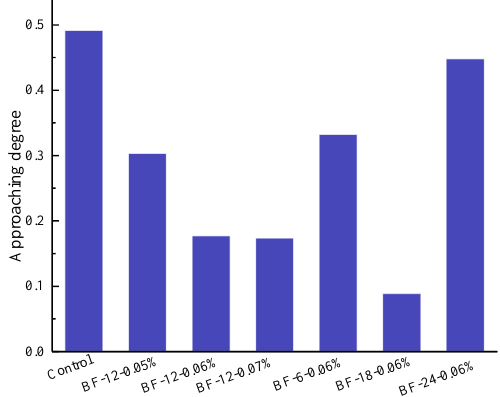
Figure 20. The approaching degree of concrete.